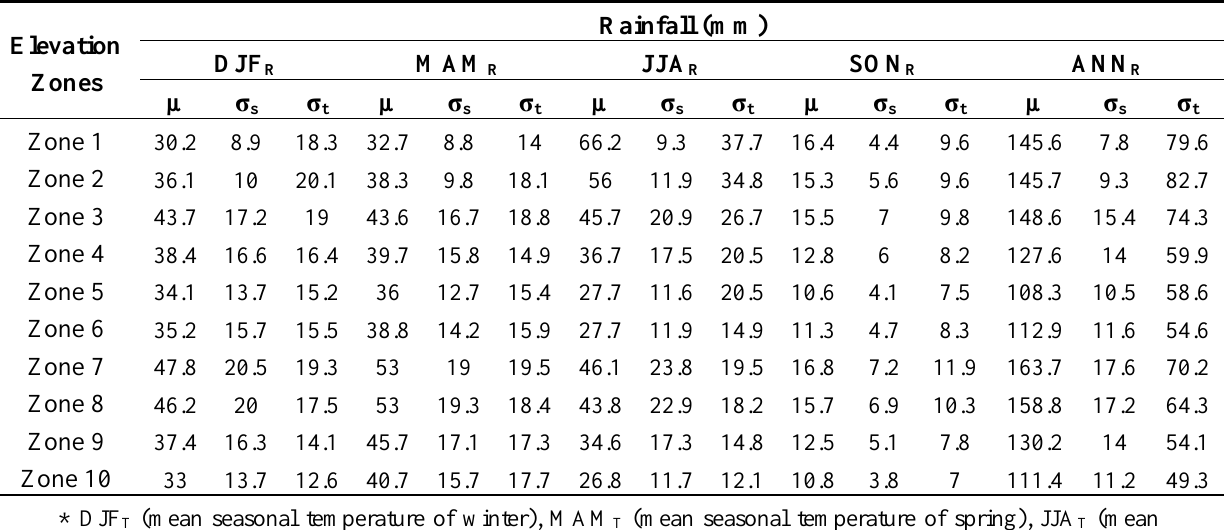
Table 2. Rainfall across the elevation zones—average temperature in each zone with the spatial and temporal